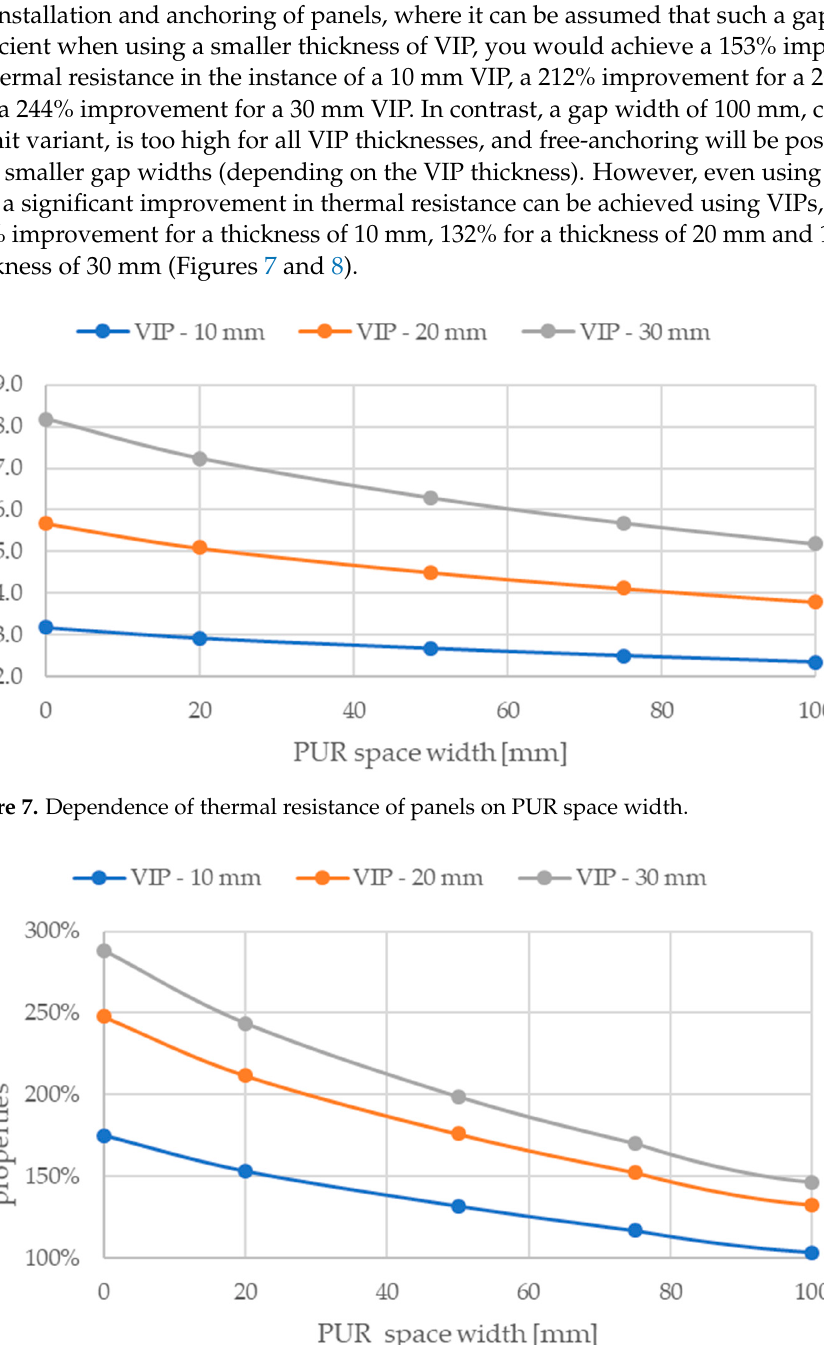
Figure 9. Dependence of the surface temperature drop on the inner surface of the panel with 10 mm VIP on the width of the gap filled with PUR foam. 6. Discussion As part of the research work carried out in this study, a conceptual design of an in- sulating panel utilising VIPs and allowing the anchoring of a green facade to the surface of the structure was developed. Different model configurations were considered from the point of view of the thickness of the vacuum insulation, which would represent the main thermal insulator in the system, with PUR gaps between them. The main purpose of in- cluding PUR peripheral gaps was to allow for the mechanical anchoring of the system to the surface of the structure (including the anchoring of a green wall system to the panels). Three VIP thicknesses of 10, 20 and 30 mm were considered. In the end, the total thickness